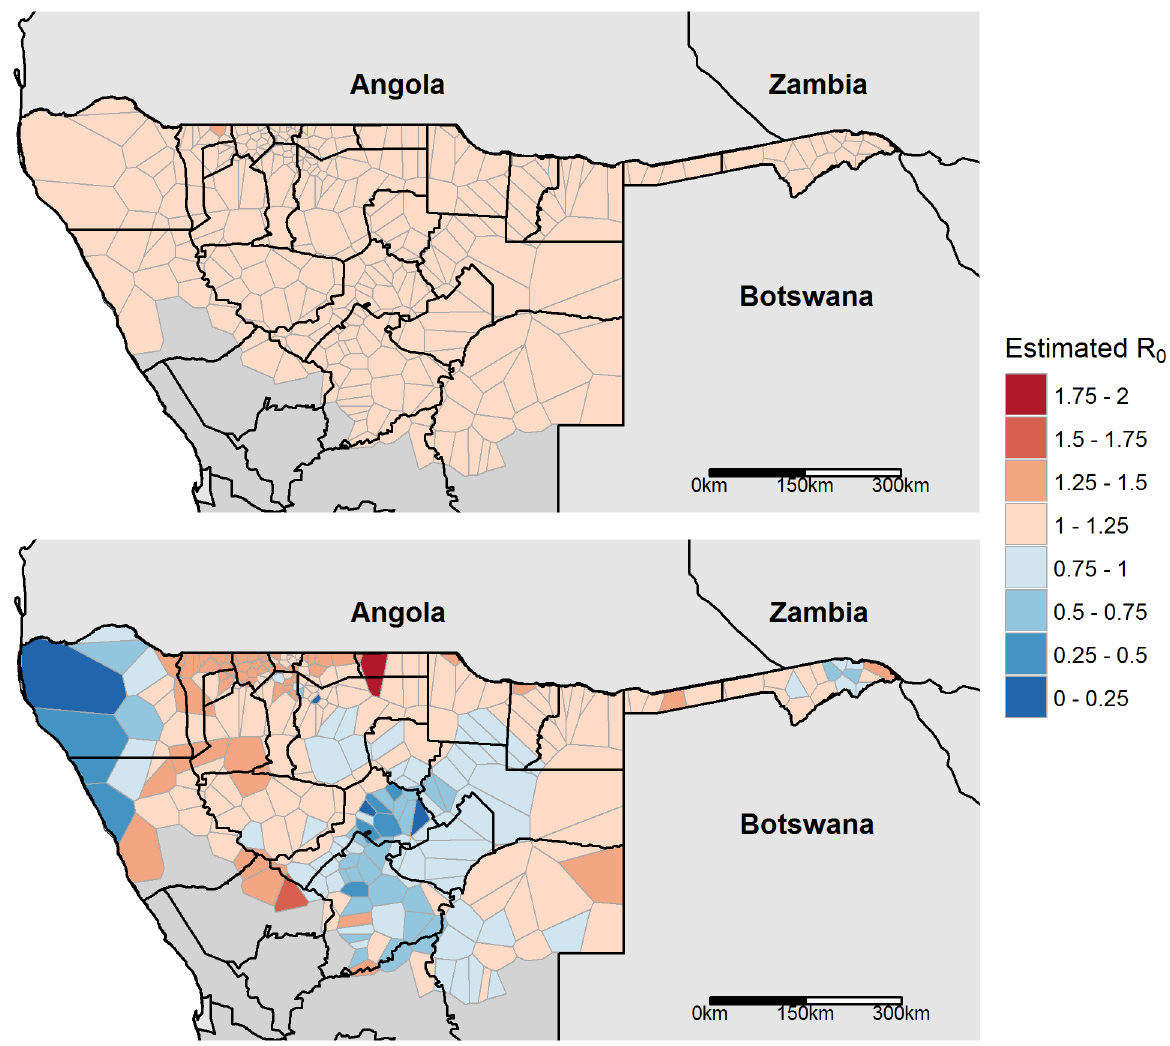
Fig 5. Predicted extent of transmission foci using pre-elimination parasite rate estimates. Top panel: Predictions from classical model analysed at steady state. Bottom panel: Predictions from multipatch model. Areas where R 0 > 1 shown in shades of red while areas where R 0 < 1 shown in shades of blue. Only areas with nonzero PR are shown; these areas were predicted to have R 0 < 1 in both models. Patch outlines shown in grey, health district boundaries in black. In the steady state analysis of the classical model, all patches with PR > 0 are predicted to have 1.25 > R 0 > 1 except one bordering Angola where R 0 = 1.27 (darker